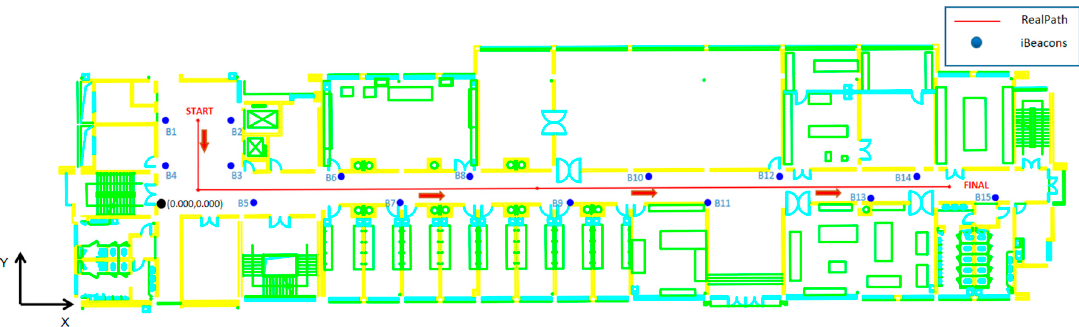
Figure 6. Collection path and iBeacons.